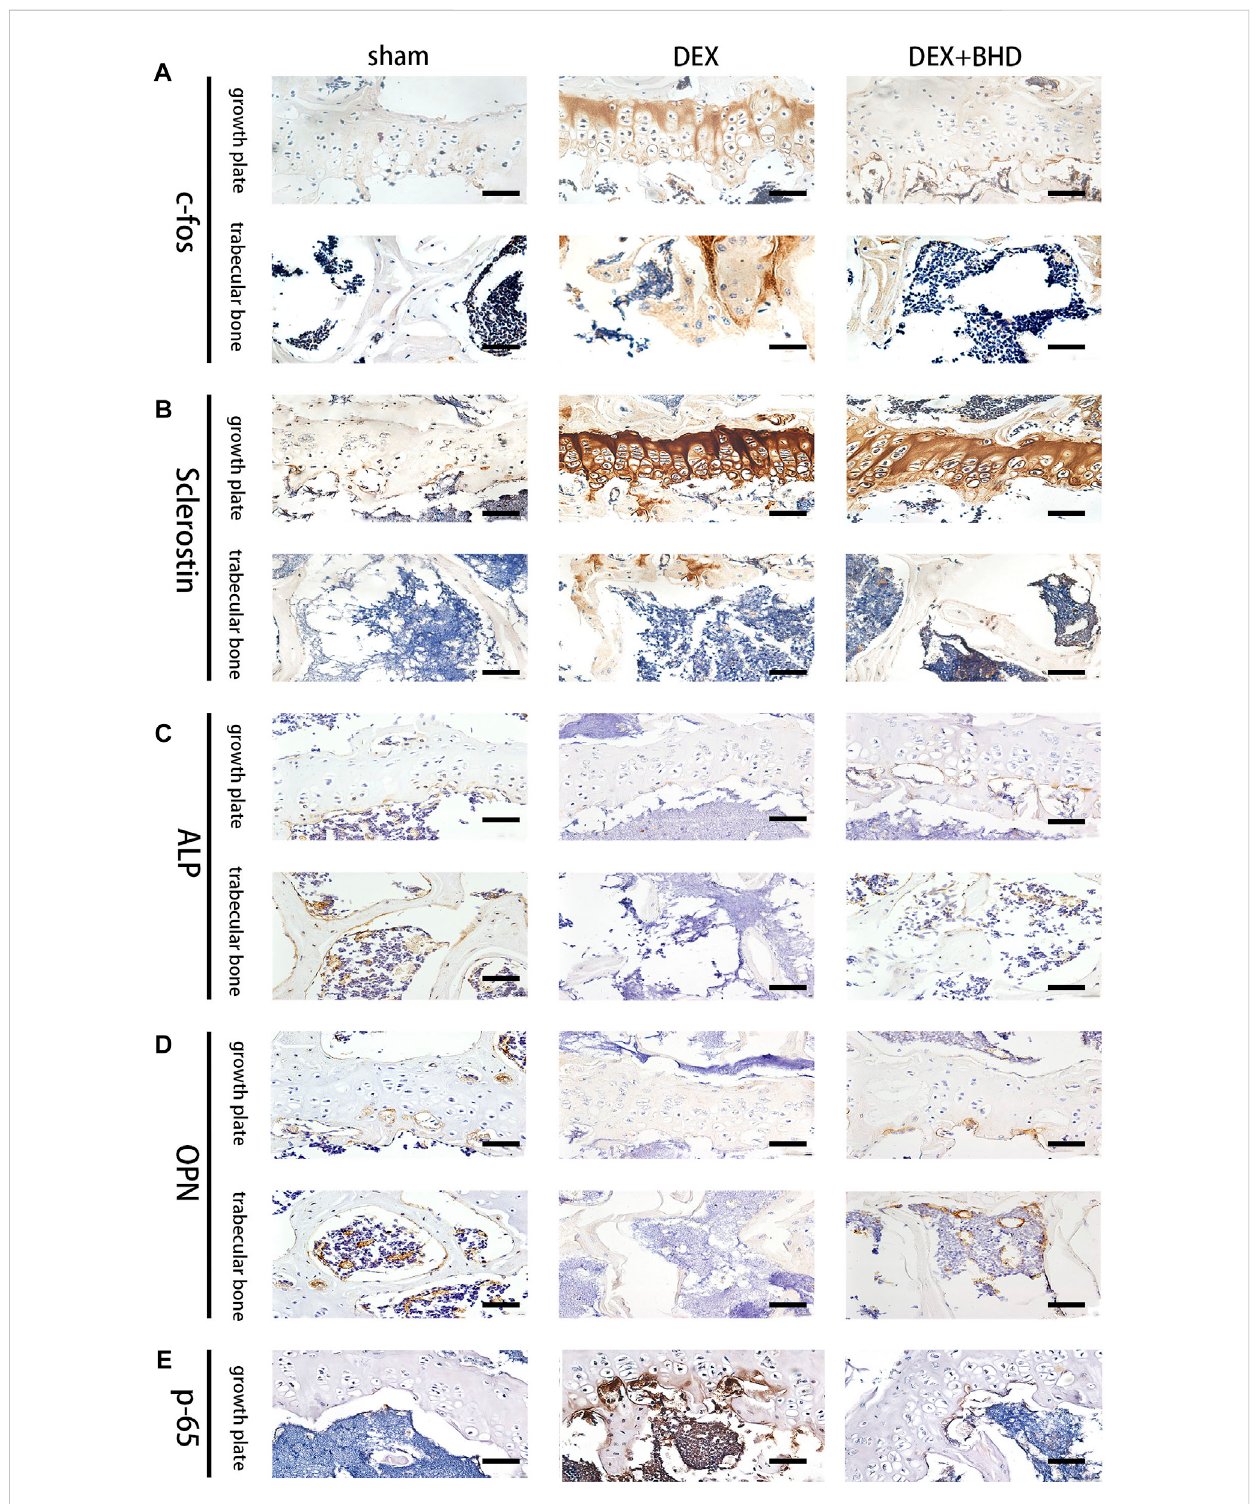
BHD affects osteoclast formation and differentiation by suppressing the expression of the NF- κ B signaling pathway in vivo. (A – E) Representative images of Immunohistochemical staining of decalci fi ed bone sections. Scale bar = 20 μ